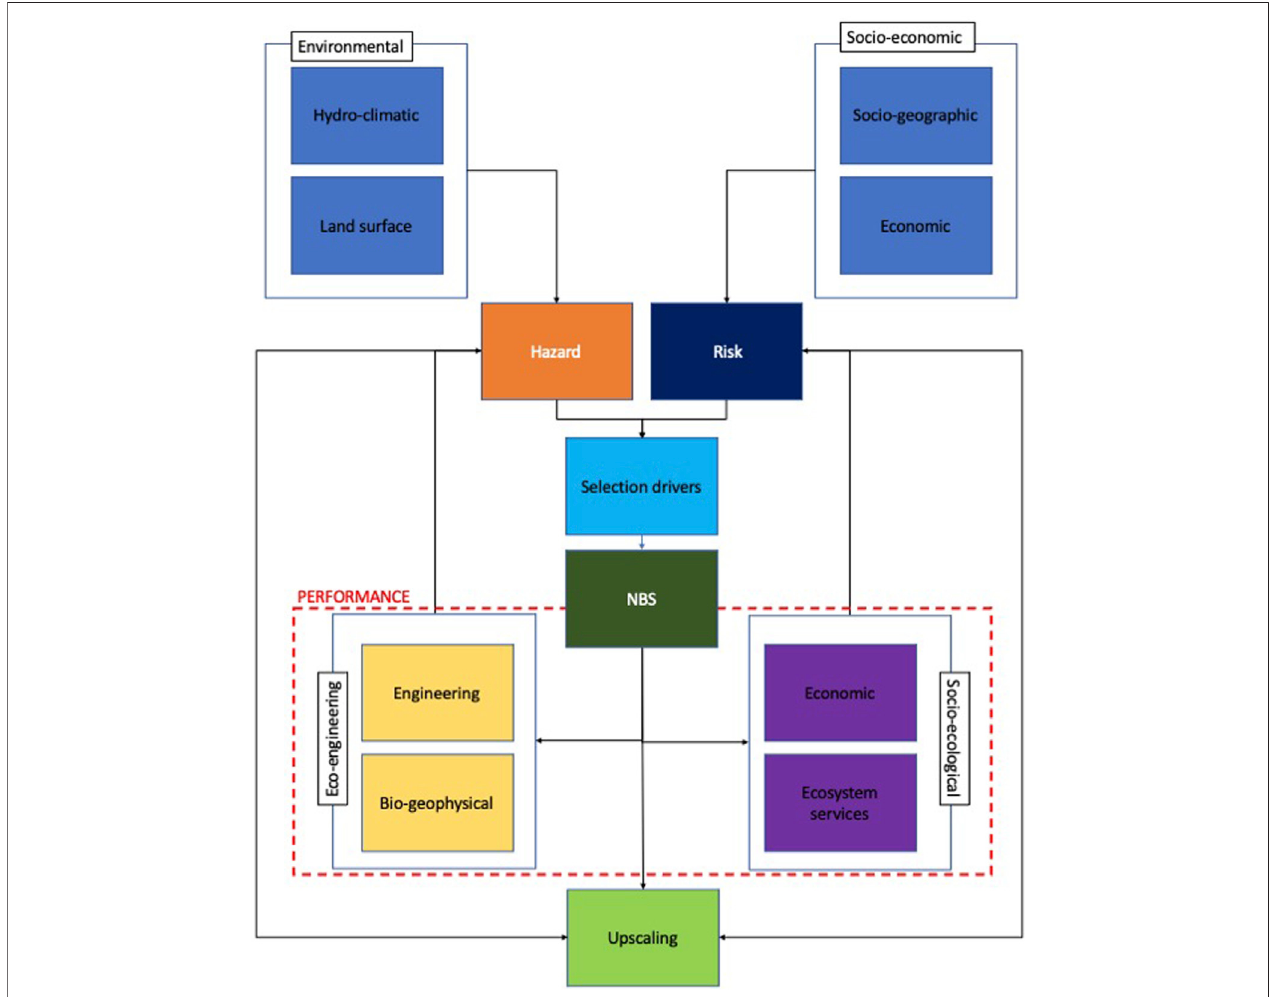
FIGURE 3 | Conceptual model illustrating the groups of indicators considered for each domain and compartment of the ‘ rocket framework ’ and their relationships throughouttheNBSprojecttimeline.Thecolouroftheboxesismatchingthecolourassignedtothedifferentprojectstagesanddomainswithintheframework( Figure2 ). The groups featuring within the red dash-line frame belong in the monitoring stage, in which the NBS performance against landslides and erosion is envisaged to be essentially assessed.